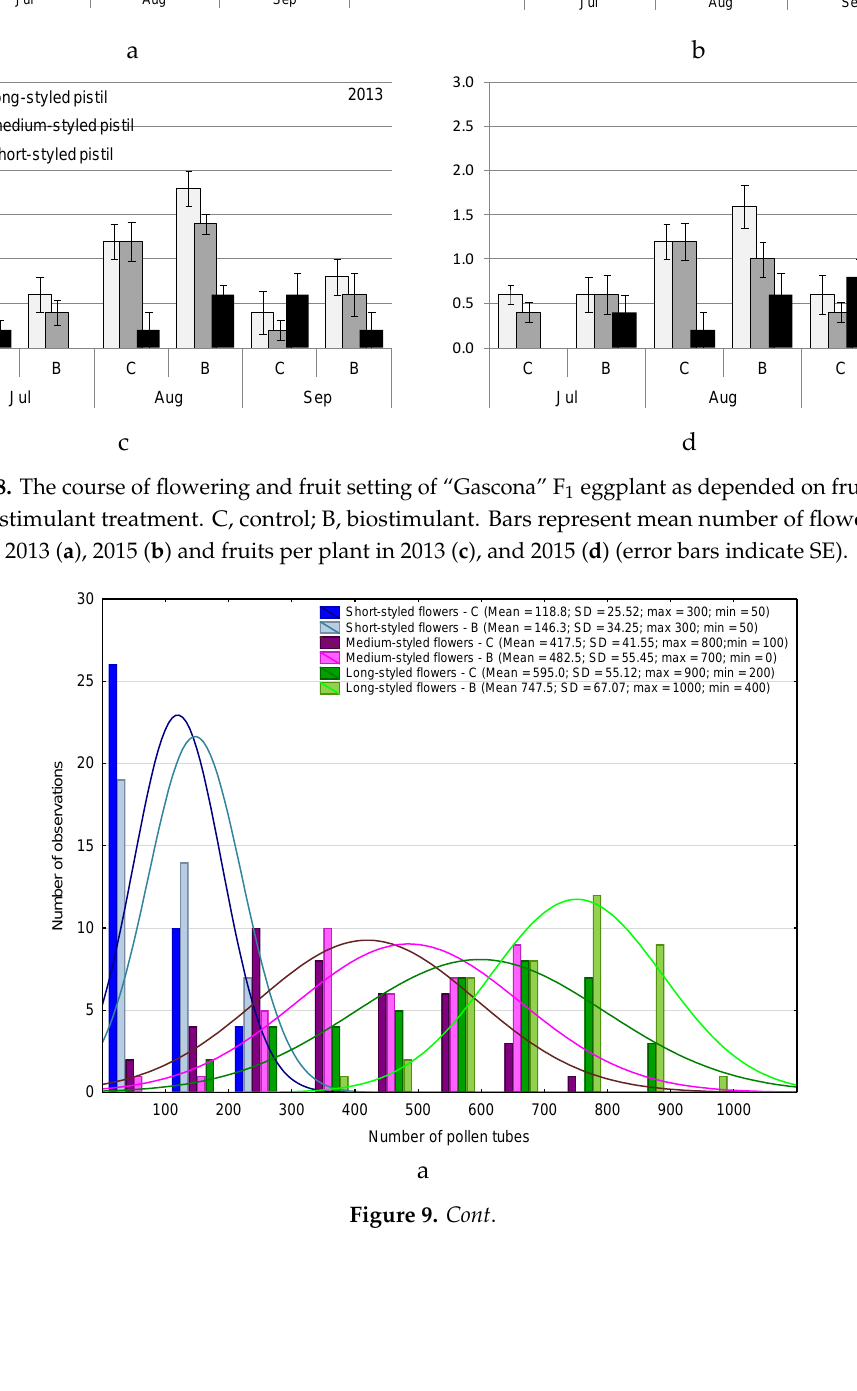
Figure 8. The course of flowering and fruit setting of “ Gascona ” F 1 eggplant as depended on fruit type and biostimulant treatment. C, control; B, biostimulant. Bars represent mean number of flowers per plant in 2013 ( a ), 2015 ( b ) and fruits per plant in 2013 ( c ), and 2015 ( d ) (error bars indicate SE). Table 5. Results of ANOVA for parameters of flowering and fruit setting of “Gascona” F 1 eggplant presented in Figure 8.